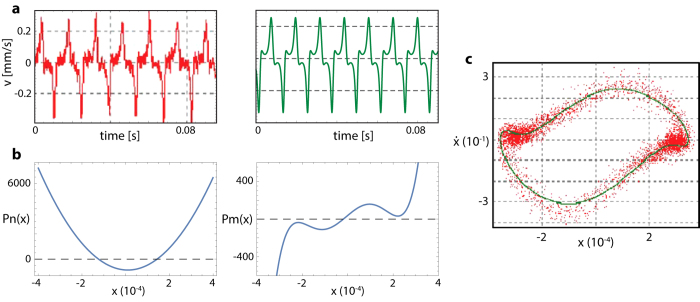
Fully developed self-sustained antenna oscillations (SO) of Drosophila, 20 min after DMSO injection (after Ref. 30).(a) Red: Data from30, green: simulations. (b) Best data-based polynomial approximating ordinary differential equation of SO , with polynomials of order n = 2 and m = 5, respectively. At extracted parameters, this system is close to a Hopf bifurcation, cf. Fig. 3. The damping term Pn(x) shows negative damping around the origin (Pn(x) < 0); the restoring force Pm(x) shows areas of negative stiffness Pm′(x) < 0. (c) Red: Data from30, green: low-passed reconstructed SO data.